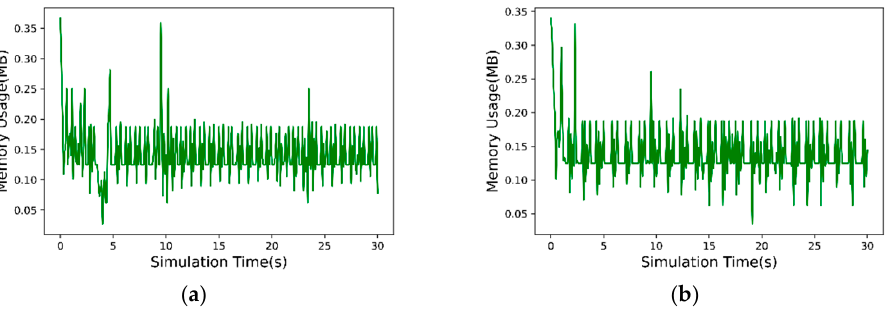
the entire simulation time in two lane change scenarios. ( a ) Scenario 1, ( b ) Scenario 2.